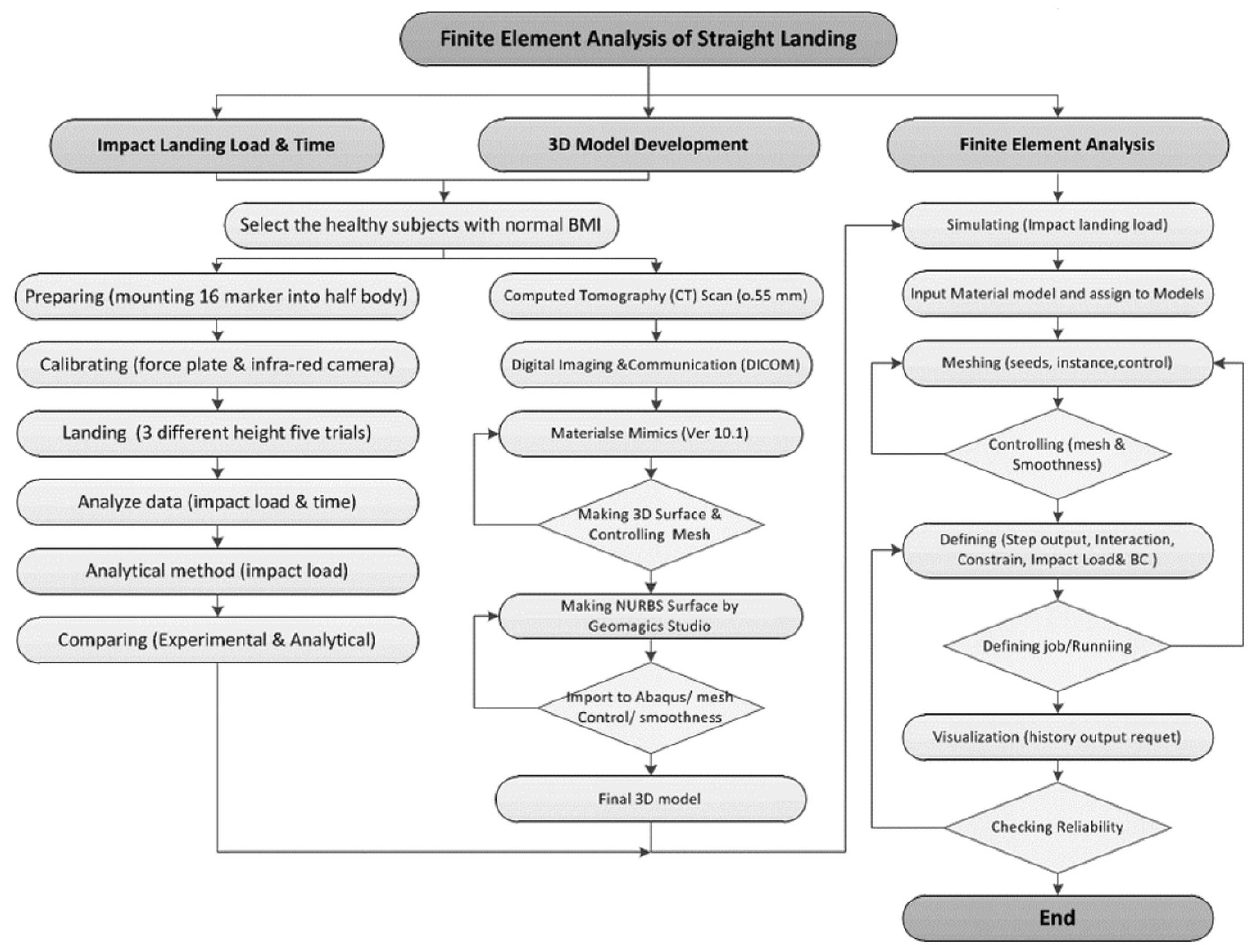
Figure 2 - General part development and finite element